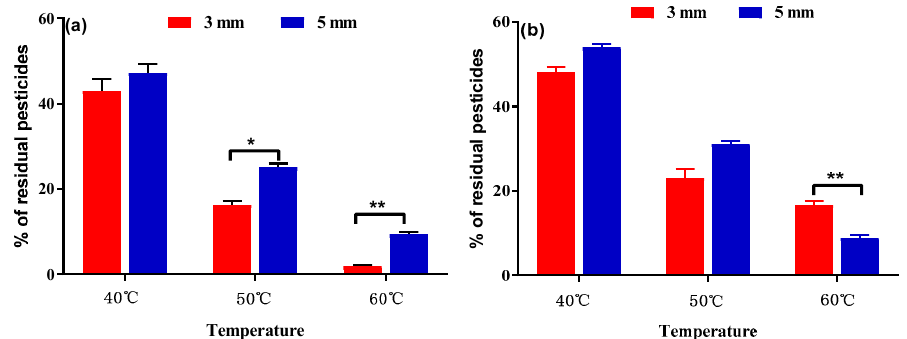
Figure 6. Effects of slice thickness and drying temperature on azoxystrobin ( a ) and difenoconazole ( b ) removal during the second drying step. Bars marked with an asterisk indicate significant differences with respect to the removal rate (* p -value < 0.05 and ** p -value < 0.01).